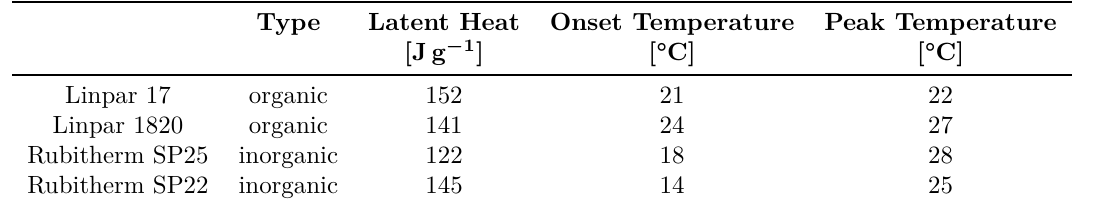
Table 1. The parameters of selected PCMs.